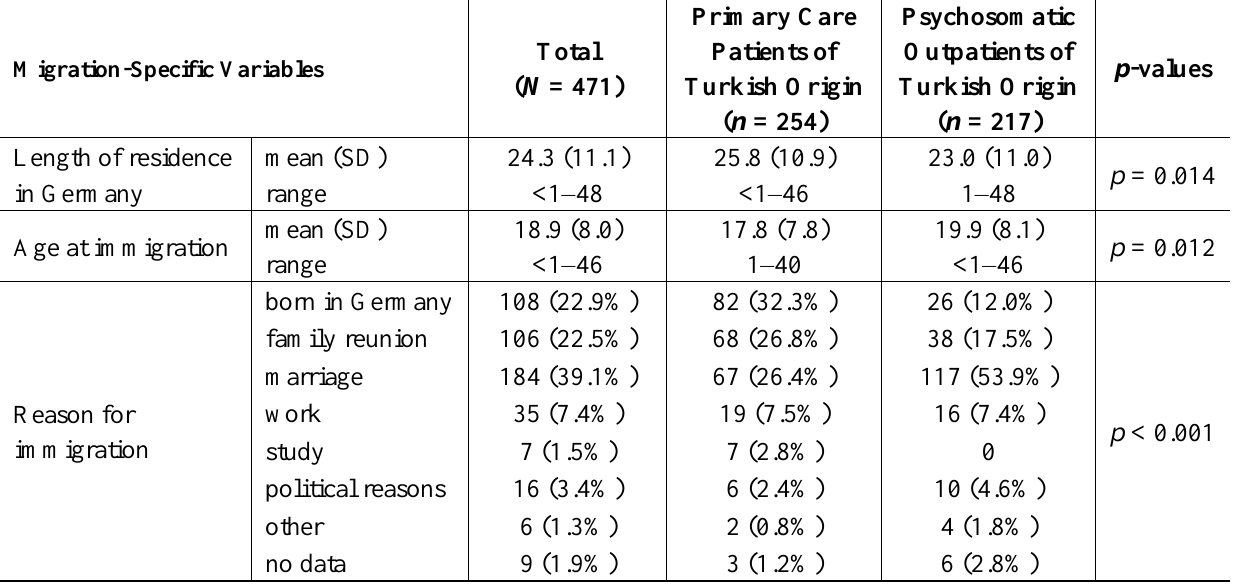
Table 2. Migration-specific characteristics of the study